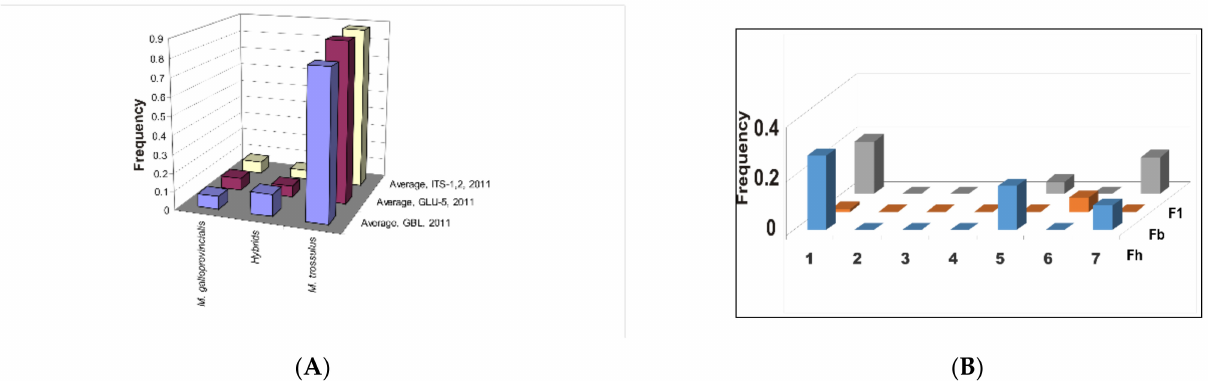
Figure 2. Two histograms of the frequency distribution of the native species M. trossulus , hybrids, and the invasive species M. galloprovincialis in mussel settlements in the NWSJ (Peter the Great Bay and adjacent waters in the Sea of Japan). The left histogram ( A ) shows a hybrid genotypic group Fh simulated in the Structure software (8 biochemical-genetic loci, GBL, and two nDNA markers, GLU-5 and ITS-1,2 ). The Y-axis in both figures is the frequencies of genotypes in the total sample from the studied settlements. The right histogram ( B ) shows examples of hybrid occurrence with small or no gene introgression, as evidenced by the decreased score levels for F b offspring. The three rows in figure ( B ) are examples of frequency variation of three types of hybrids (F h , F b , F 1 ) of the two mussel species. On the X-axis are the numbers of samples from mussel settlements in the NWSJ (Modified from